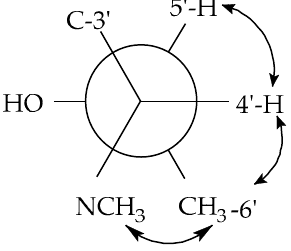
Figure 5. J -based analysis of 4 ′ -H/5 ′ -H bond. Arrows indicate observed ROESY correlations.